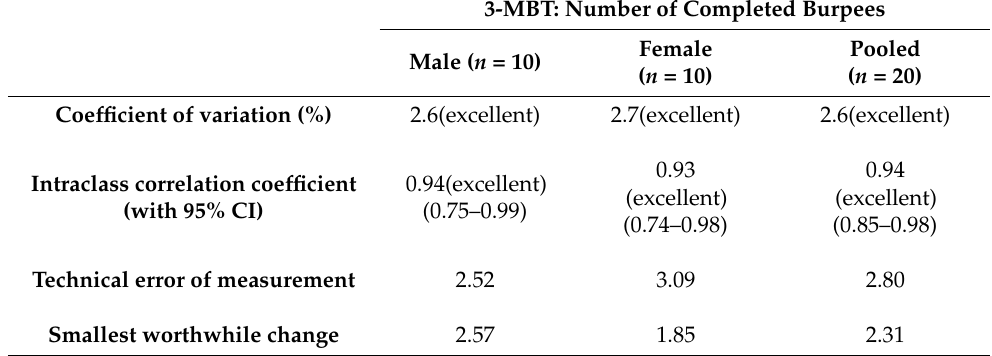
Table 3. Part I (reliability): Coefficient of variation (CV), intraclass correlation coefficient (ICC) with 95% CI, technical error of measurement (TEM) and smallest worthwhile change (SWC) of the number of burpees completed in the 3-min burpee test (3-MBT) among male and female